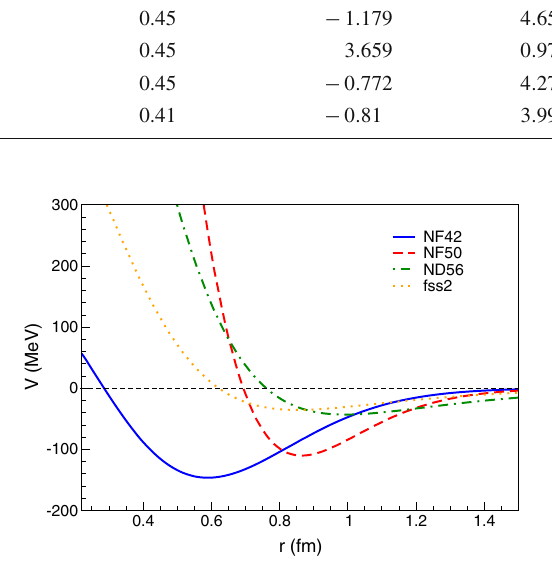
Fig. 4 (cid:2) – (cid:2) interaction potentials as a function of the relative distance r . The parametrization in Eq. (10) is taken from